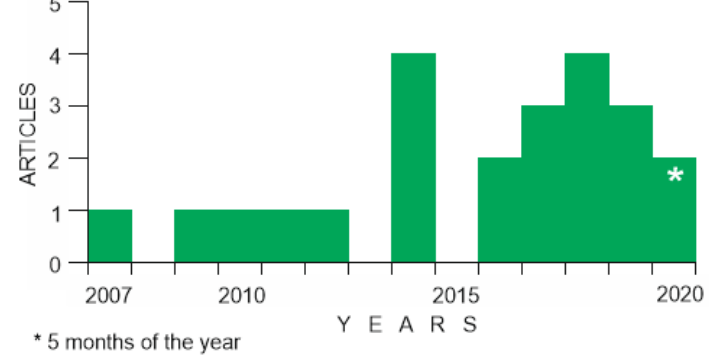
Figure 1. Publishing activity related to the research in geoheritage and climbing activities.